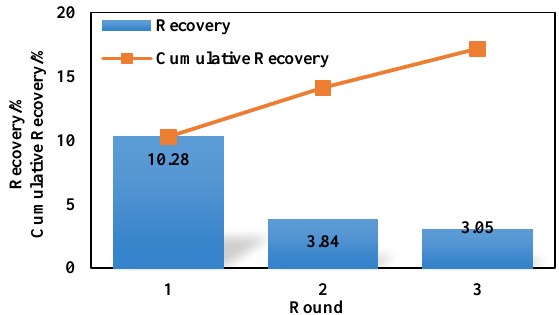
Figure 7. Recovery factors of three rounds of air HnP.